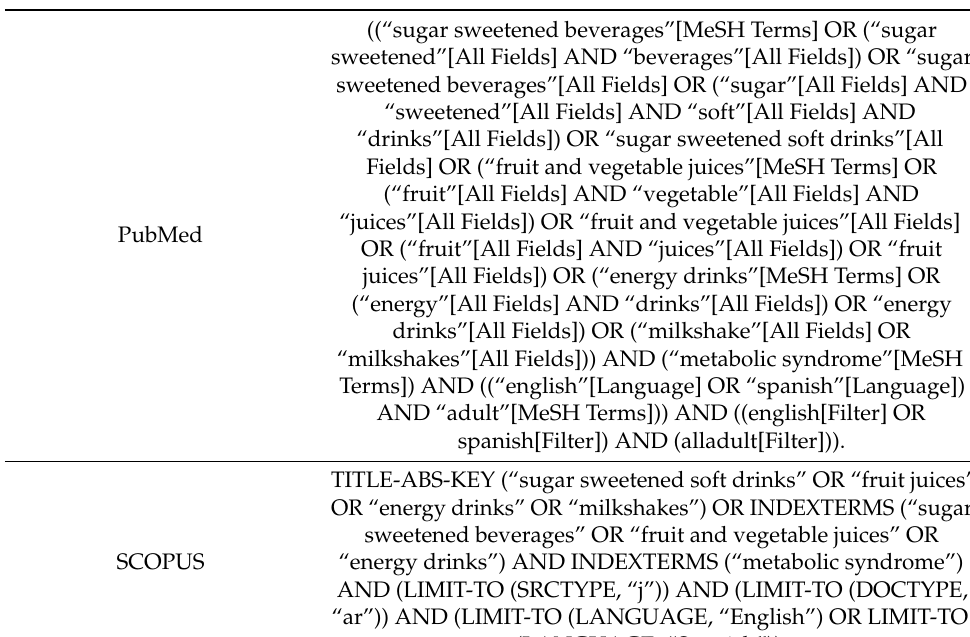
Table 1. Search strategy in selected